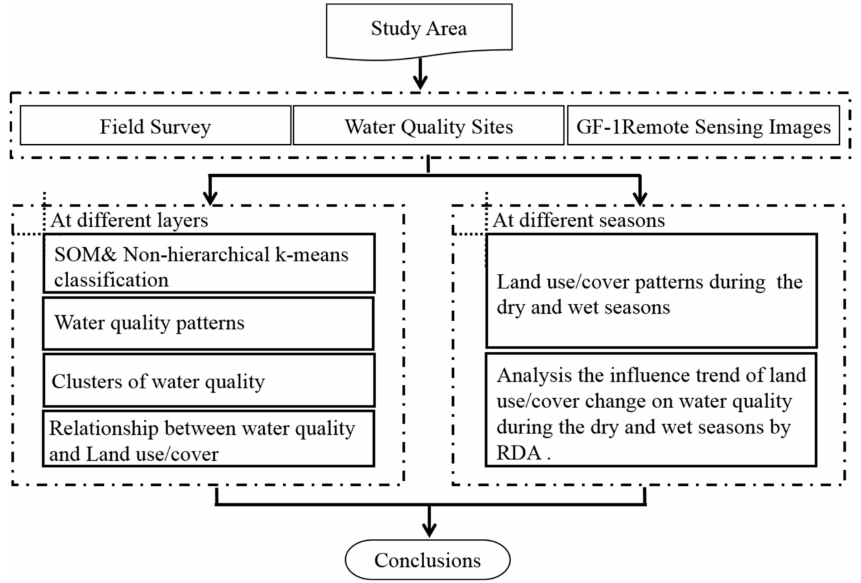
Figure 2. Conceptual model of the